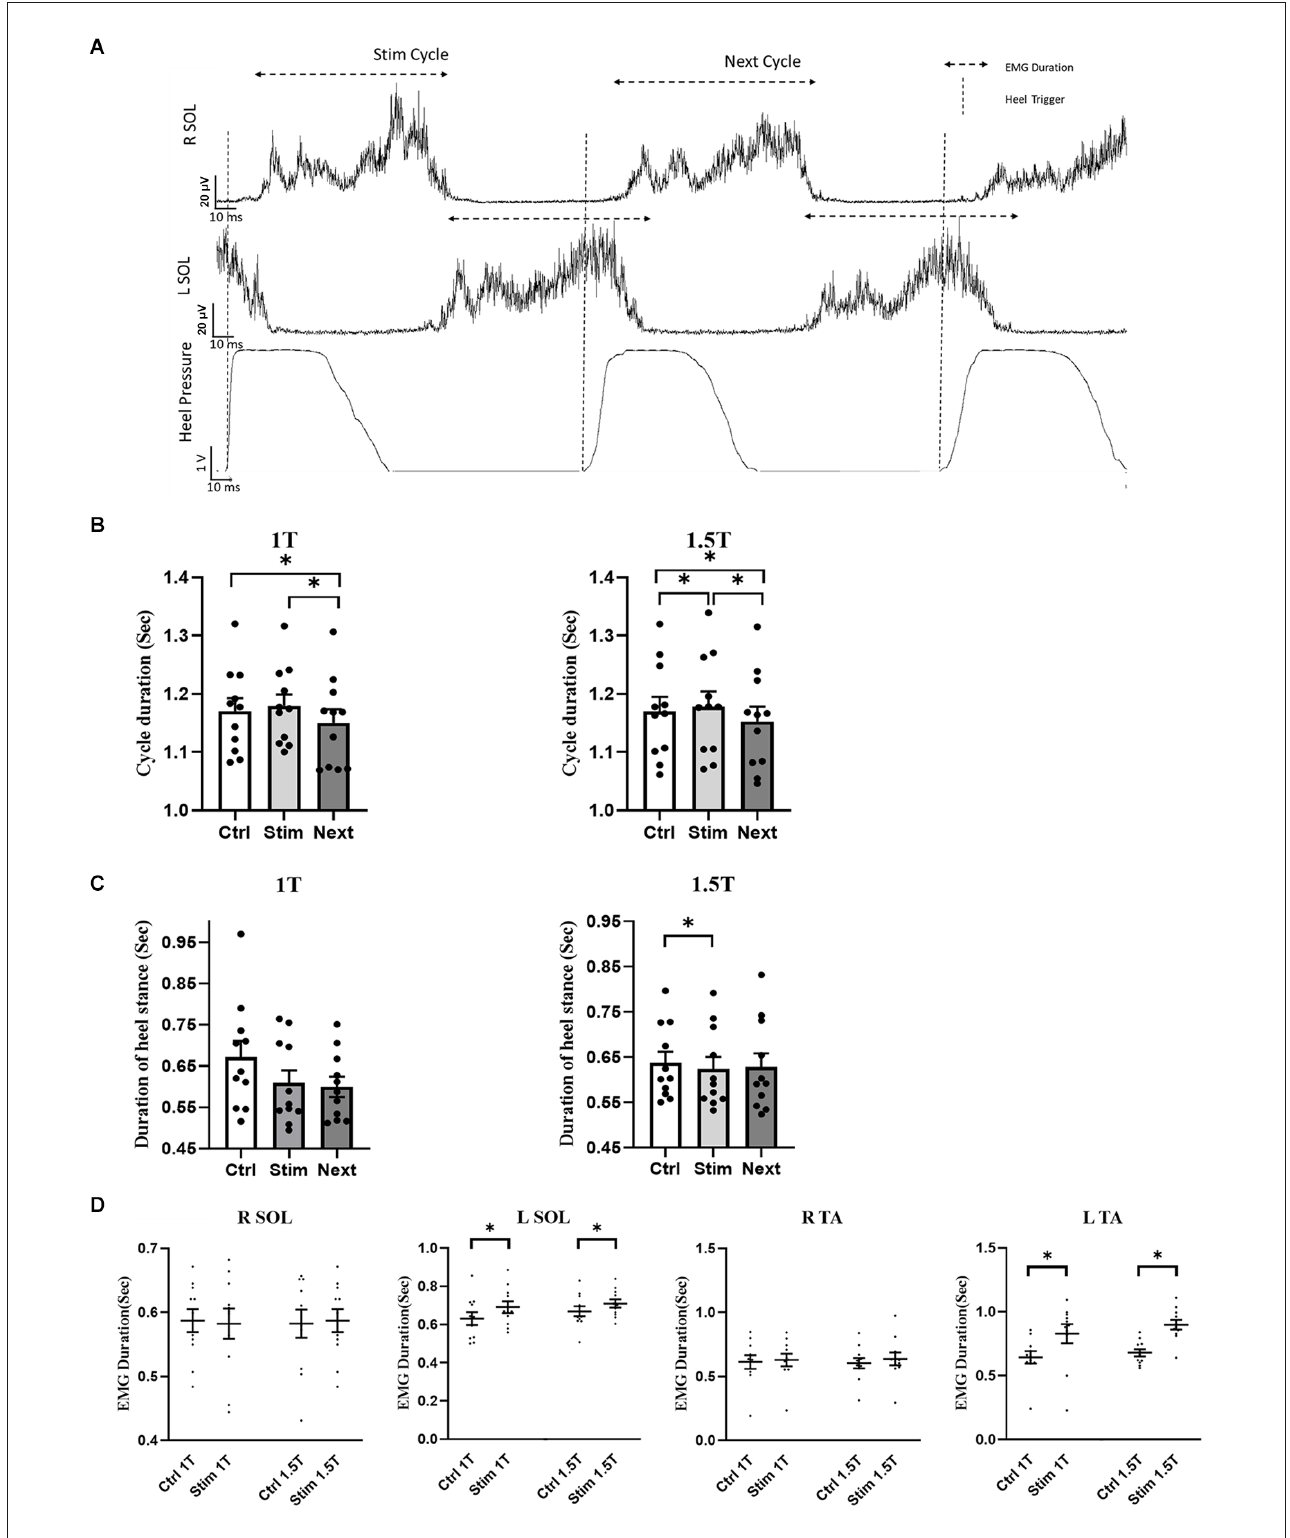
FIGURE4 R Cathode Configuration. (A) Averaged and rectified EMG signal of left and right soleus (SOL) muscles during locomotion. The gait cycle duration was measured during stimulation (Stim cycle) and also for the cycle following the stimulation (Next cycle), as well as in a control cycle (not shown). (B) The group data show that the duration of the Stim cycle increases significantly during stimulation at 1.5 T, but not at 1 T. Furthermore, next cycle duration is significantly decreased compared to the control cycle, and the Stim cycle at both 1 T and 1.5 T. (C) Duration of the heel stance was decreased in the stim cycle compared to control, which was statistically significant only at 1.5 T. No significant difference was detected for the Next cycle. (D) The duration of the EMG burst in LSOL, and LTA was increased in the Stim cycle compared to control at both 1 T and 1.5 T. No significant difference was observed in the duration of RTA and RSOL EMG burst during Stim Cycle. Statistical significance is shown with an asterisk ( ∗